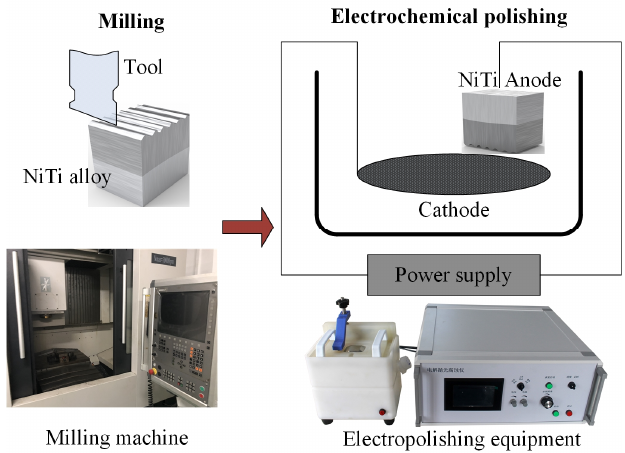
Figure 1. Schematic diagram of processing technology and